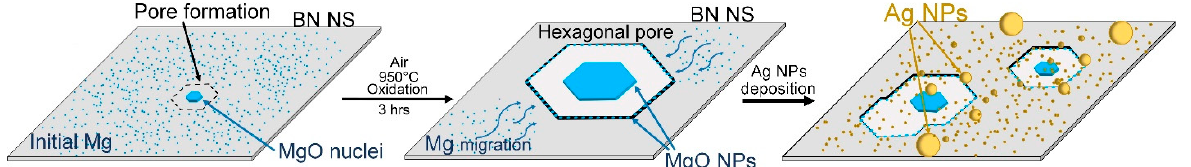
Figure 1. Scheme for obtaining Ag nanoparticles supported on BN samples with hexagonal-shaped surface defects and defect-related MgO nanoparticles.